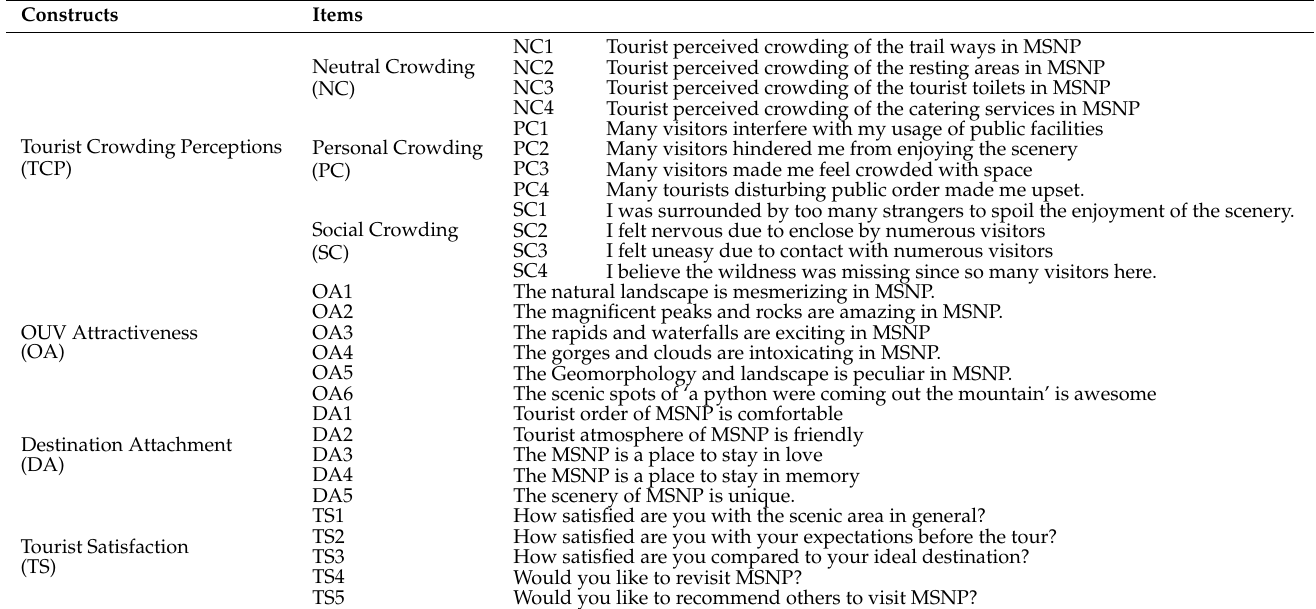
Table 1. Constructs and measurement